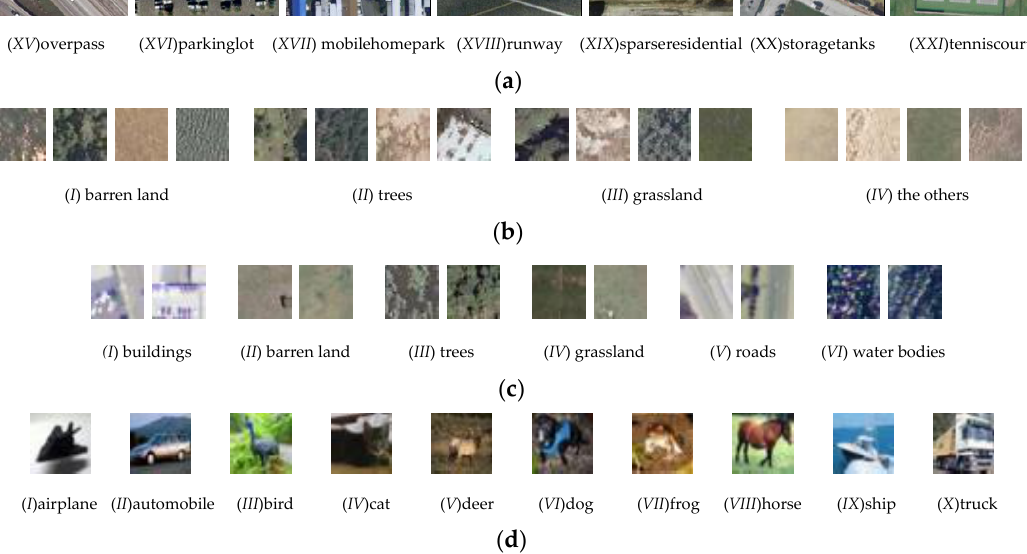
Figure 3. Sample images of four datasets: (a) UCMD; (b) SAT4; (c) SAT6; and (d) CIFAR10.